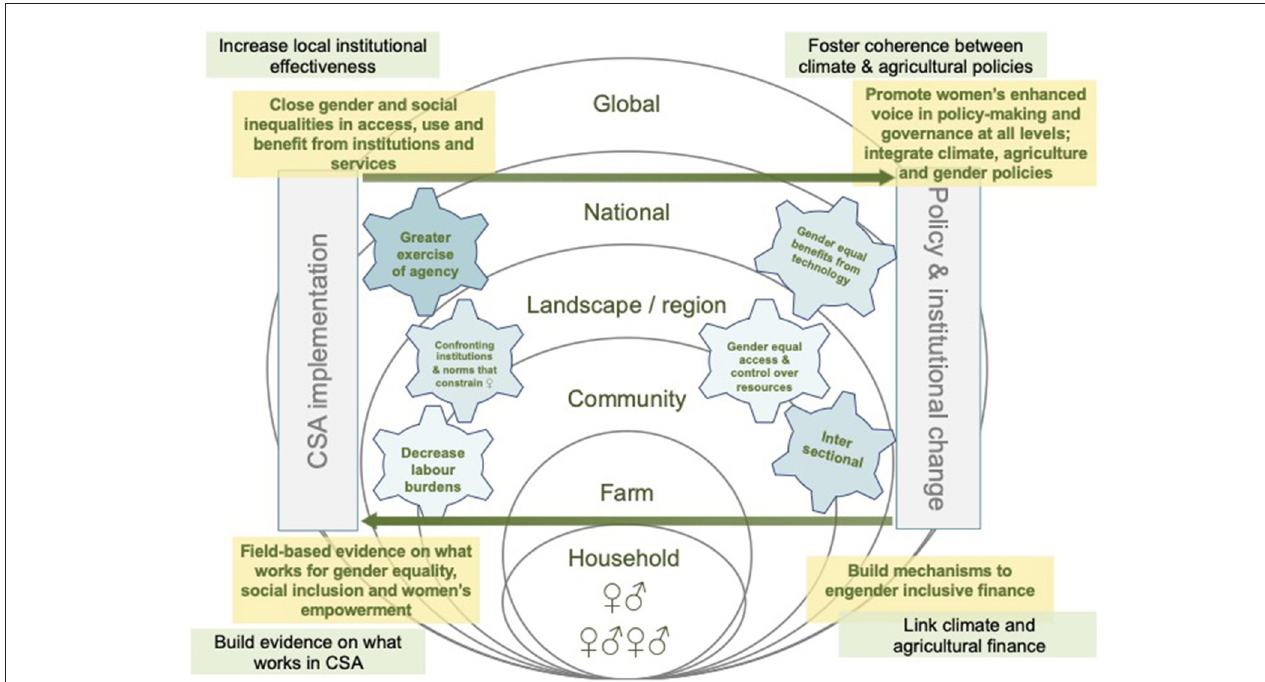
FIGURE 3 | Empowerment and CSA: a GSI scaling